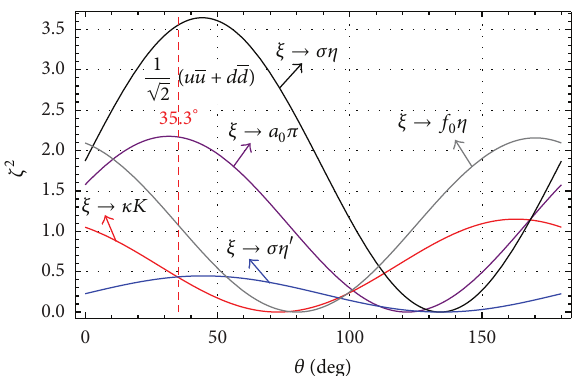
Figure 3: The coefficients 𝜁 2 of the isoscalar meson 𝜉 versus the mixing angle 𝜃 .